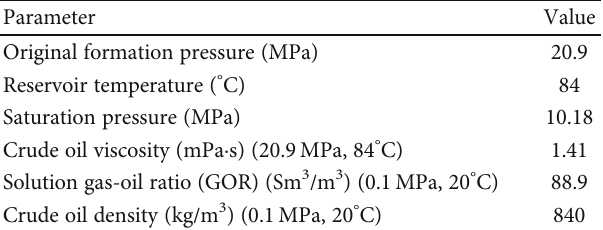
Table 1: The physical properties of the tight oil reservoir. Parameter Value Original formation pressure